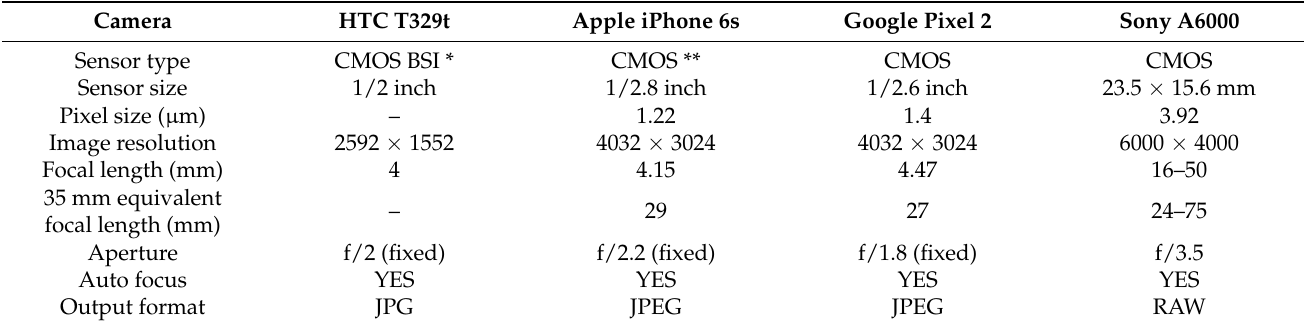
Table 1. Basic parameters of three smartphone cameras and a mirrorless camera.